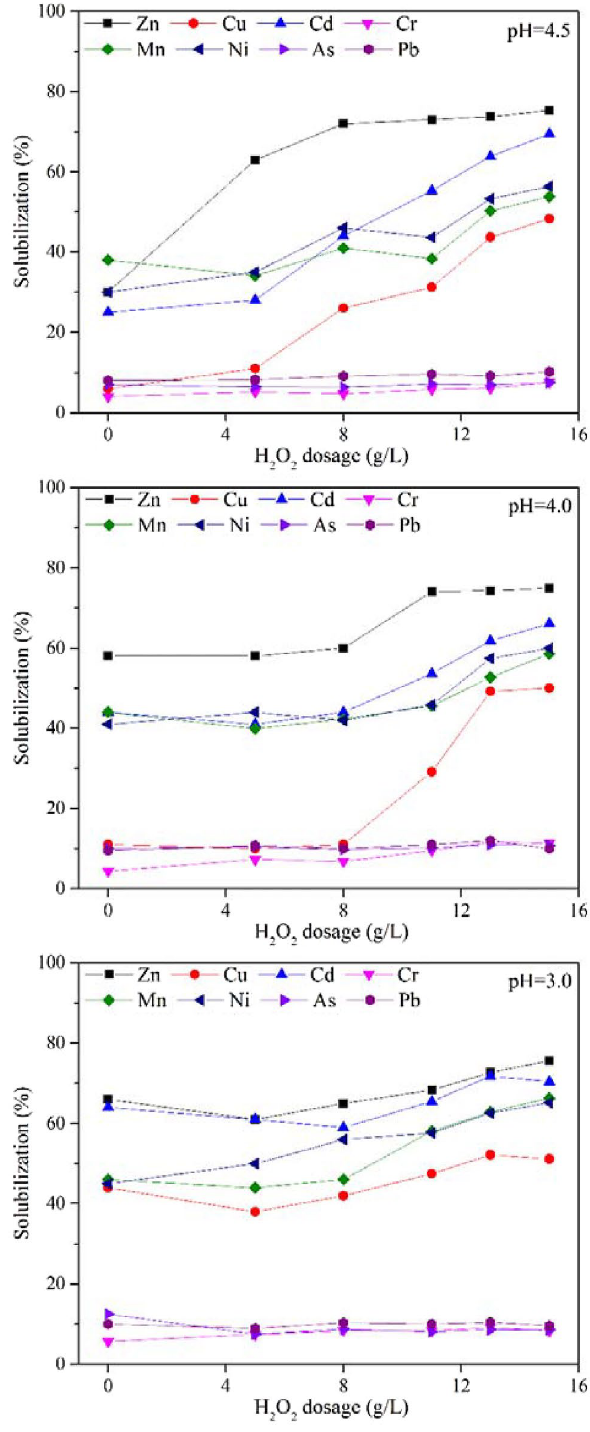
Figure 4. Effects of H 2 O 2 dosage on the removal efficiency of heavy metals under various pH